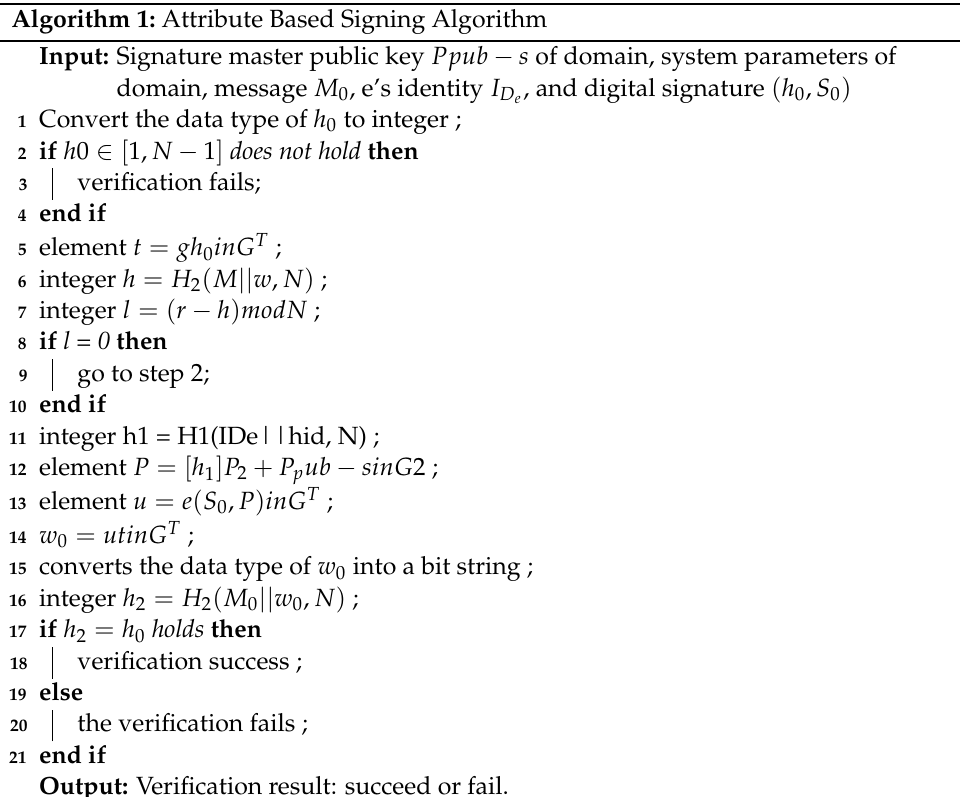
Algorithm 1: Attribute Based Signing